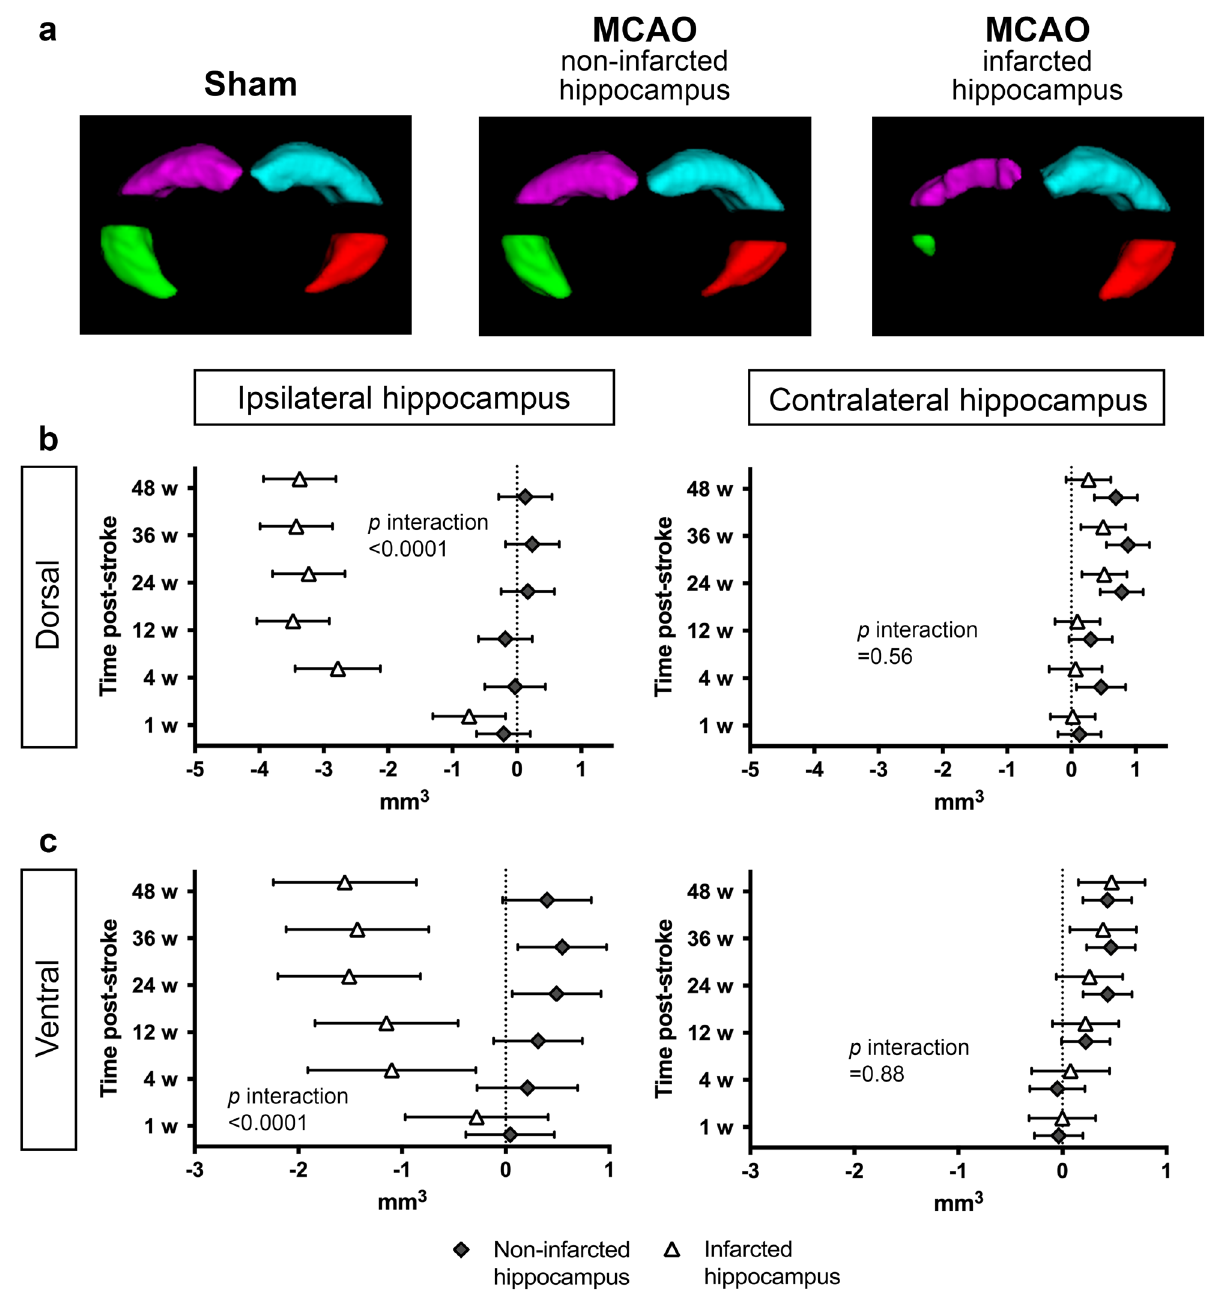
Figure 4. Dorsal and Ventral Hippocampal Volumes. ( a ) Representative 3D images of a sham-operated mouse, an MCAO-operated mouse with a non-infarcted hippocampus, and an MCAO-operated mouse with an infarcted hippocampus with automatic segmentation of the dorsal ipsilateral (purple), dorsal contralateral (aqua), ventral ipsilateral (green) and ventral contralateral (red) hippocampi at 12-weeks post-surgery. Volume changes of the dorsal ( b ) and ventral ( c ) ipsilateral and contralateral hippocampus in MCAO-operated mice with a non-infarcted hippocampus (gray diamonds) and with an infarcted hippocampus (white triangles) at each time point measured (n = 3–6). Random effect generalized least squares regression test. The effect sizes are presented as mean differences in volume (mm 3 ) between the given time point and baseline with corresponding 95% confidence intervals ( p < 0.05 when the error bars do not touch the dotted line at 0, and the further the deviation from this, the greater the